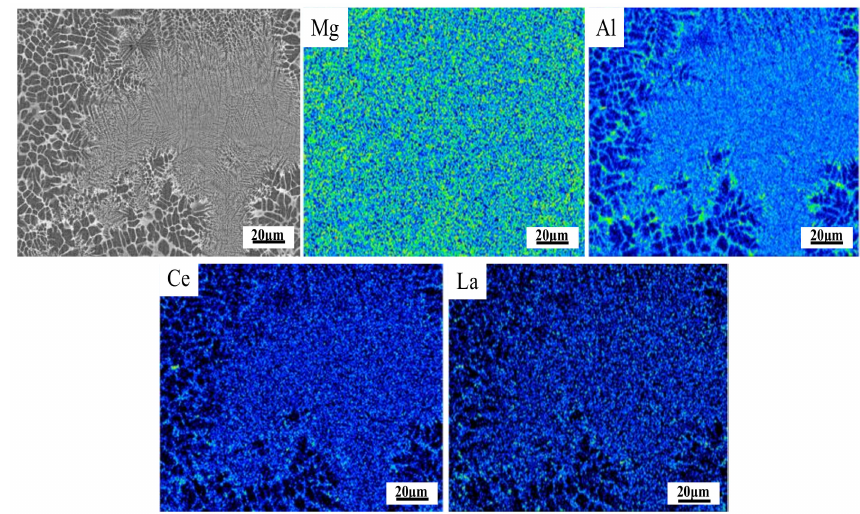
Figure 4. The major element distribution of the Mg-RE alloy sheet with TRC samples.